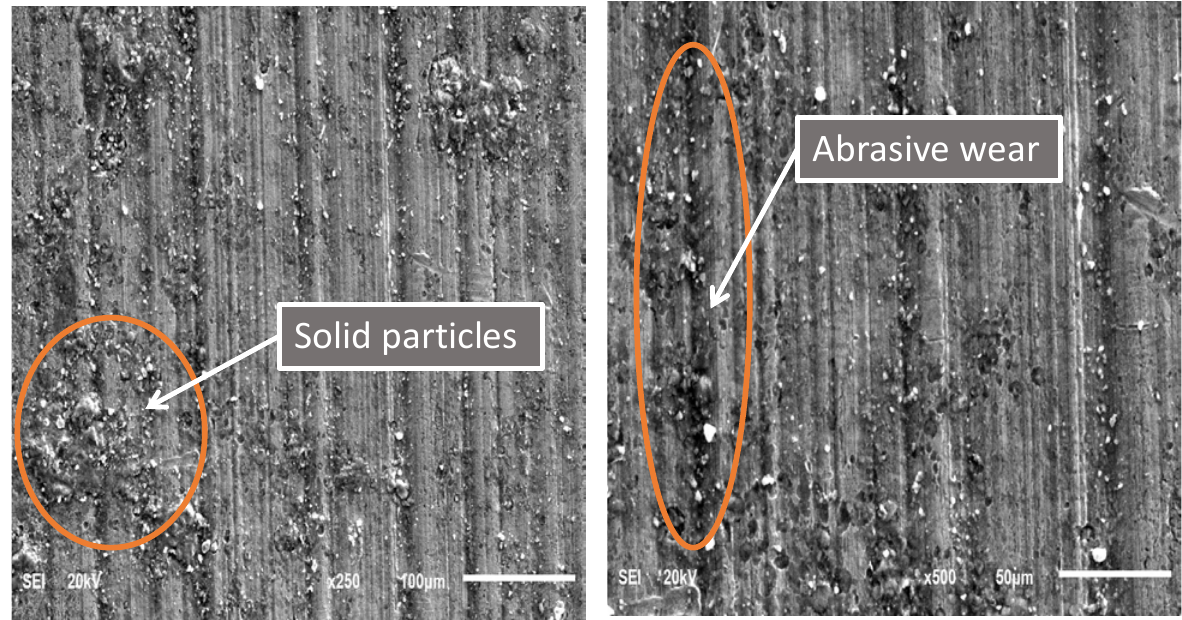
Figure 10. SEM images of a P110 worn casing sample (S2) tested under wet conditions (oil-based drilling fluid) at 115 rpm and 1000 N.